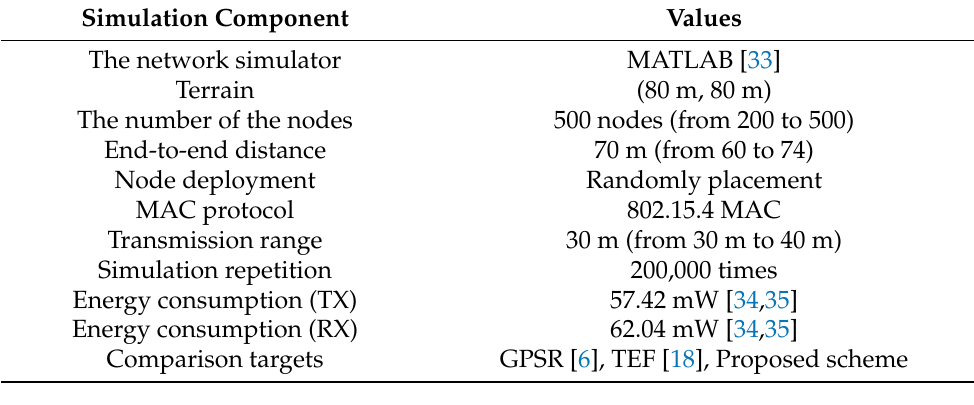
Table 1. The Components of the Simulation Environment.